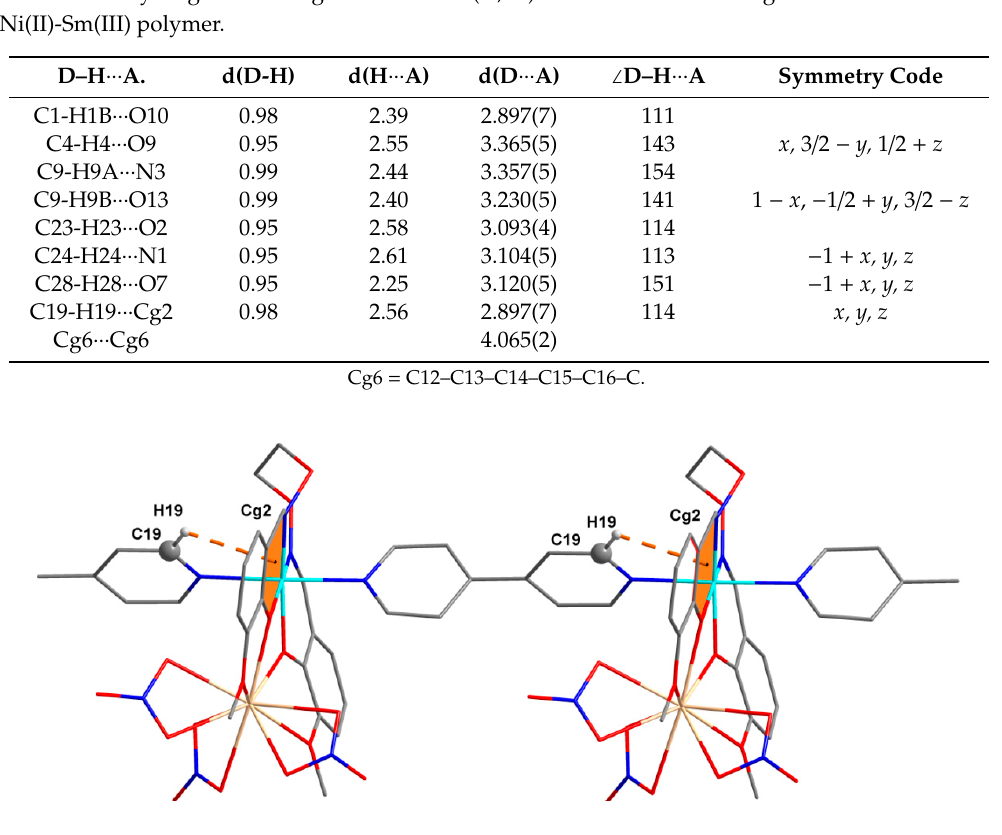
Figure 5. View of the intramolecular C–H··· π interactions.